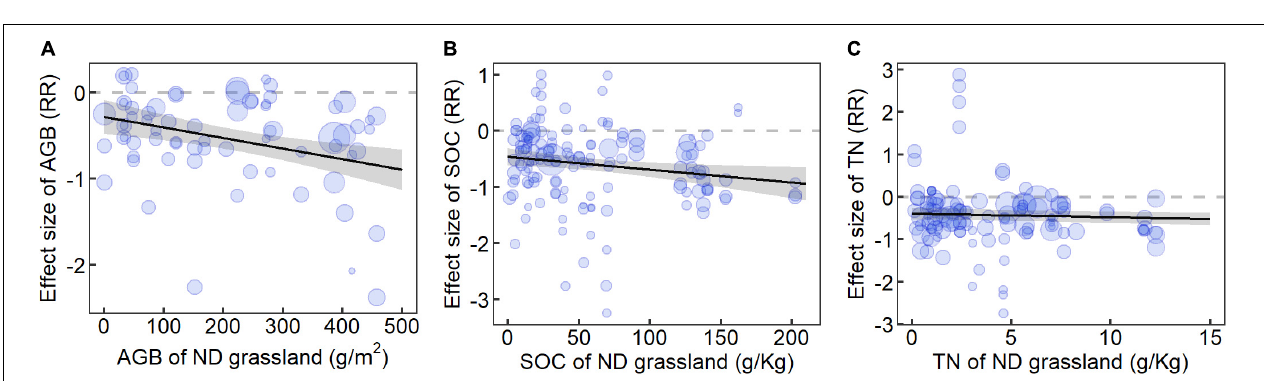
FIGURE 3 | Change in soil total nitrogen with (A) mean annual temperature and (B) MAP. RR, response ratio. RR = 0, dashed gray line; predicted mean effect size (with 95% CI in gray), black lines. The size of data points (in blue) is proportional to the sampling variance. Results were obtained with single meta-regressions.